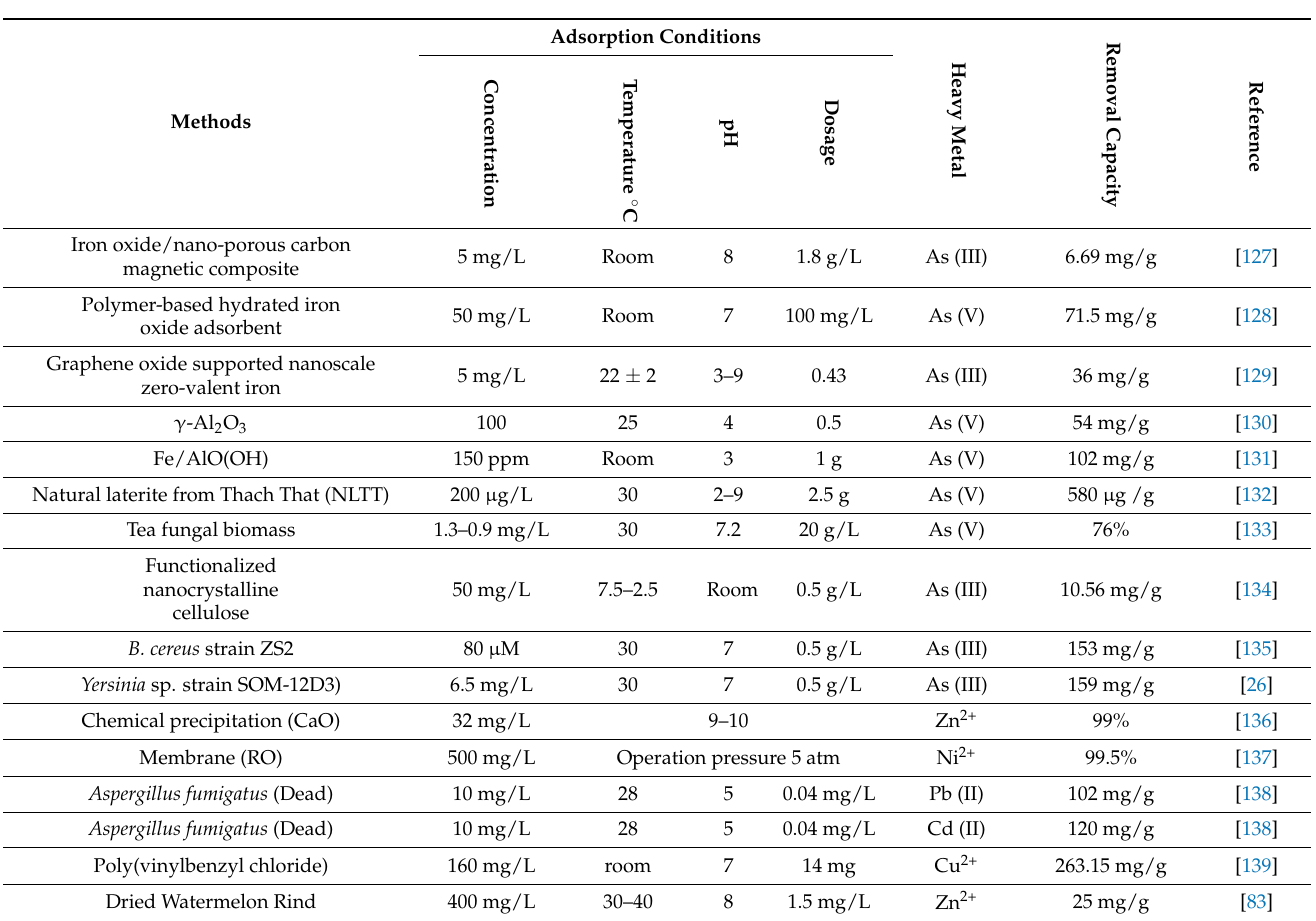
Table 5. Comparative evaluation of different adsorbents and methods for heavy metal removal under different operational